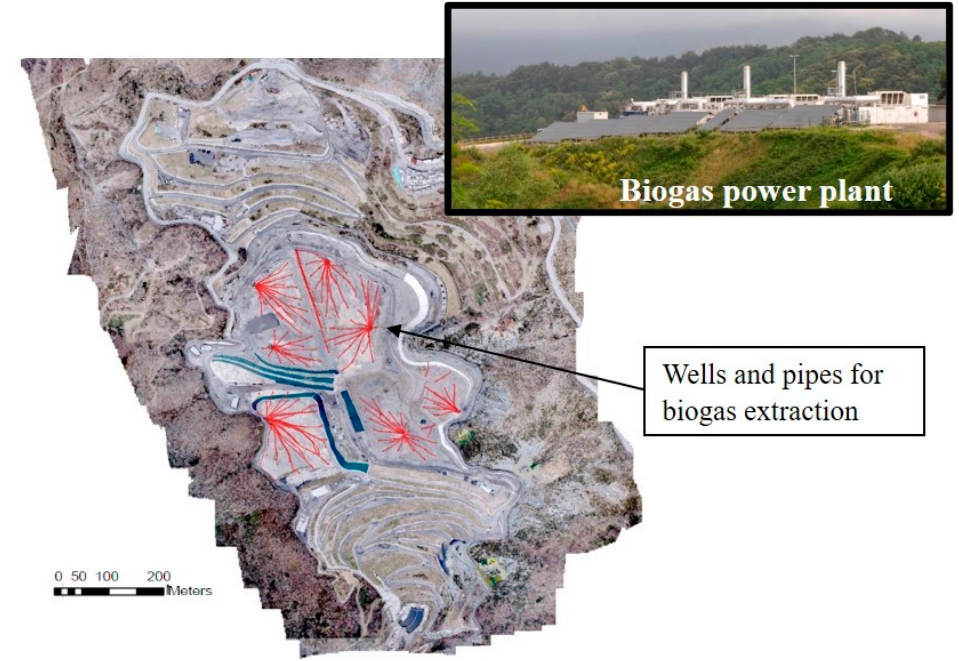
Figure 1. Topographic view of the landfill of Mount Scarpino (Genoa, Italy). Wells and pipes for the biogas extraction are highlighted.